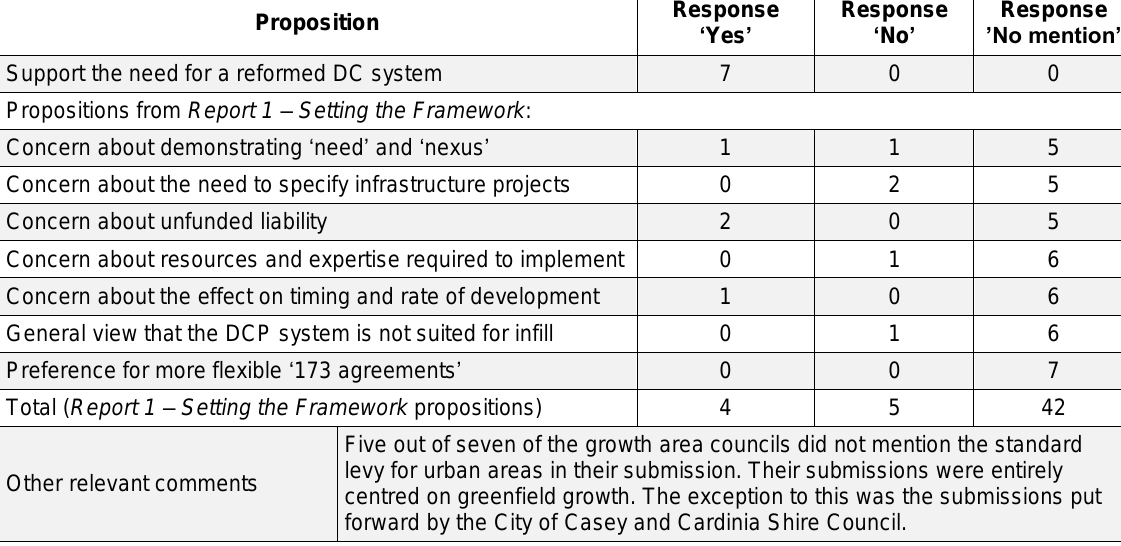
Table 2: Summary of document analysis findings for growth area